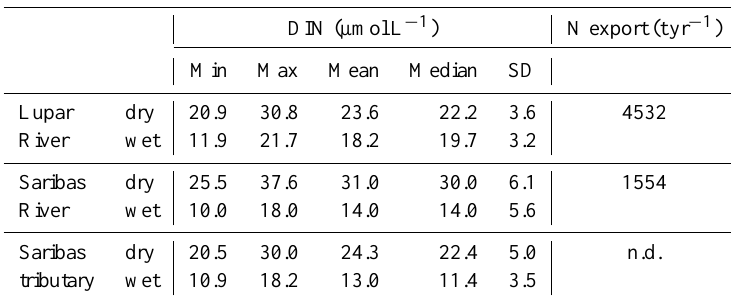
Figure 3. Dissolved N 2 O (a, b) and CH 4 (c, d) concentrations measured during the 2013 (left) and 2014 (right) MLD campaigns. Table 1. Estuarine DIN concentration medians for the spatial extent that was covered in 2013 and the estimated inorganic N export to the South China